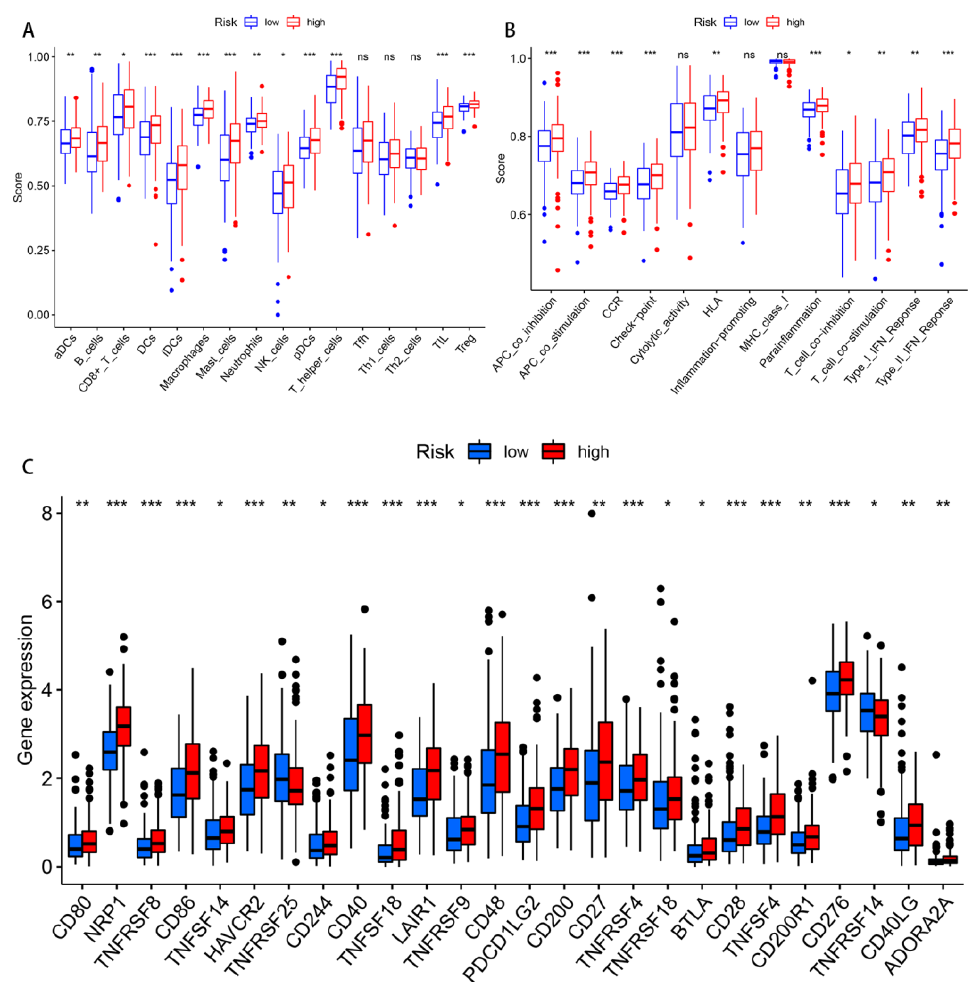
Figure 9. Differences in the immune-infiltrating cells and immune-related functions between the two risk groups. ( A , B ) The infiltration levels of the immune cells, as well as the immune-related function scores in the high- and low-risk groups. ( C ) The expression of the immune checkpoints in both risk groups. Abbreviations — ns: non-significant. * p < 0.05; ** p < 0.01; and *** p < 0.001.